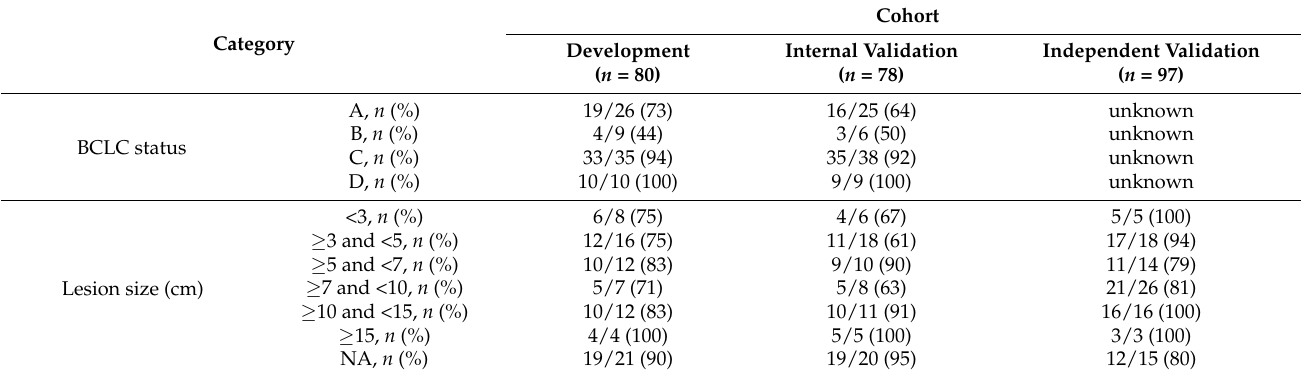
Table 3. Sensitivity of the test in HCC subgroups depending on tumor size and BCLC status.